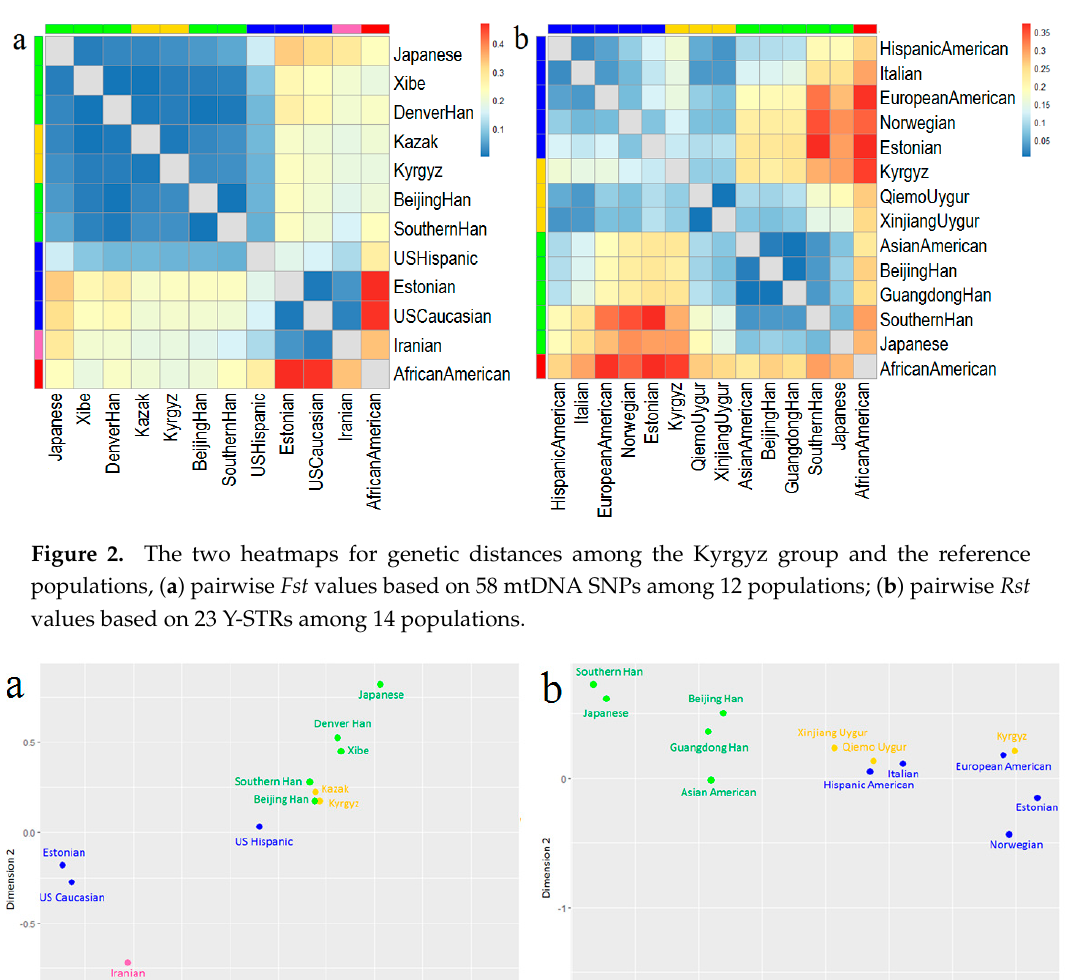
Figure 4. The neighbor-joining (NJ) trees for the Kyrgyz group and reference populations, ( a ) based on the same of 58 mtDNA SNPs; ( b ) based on the same of 23 Y-STRs.